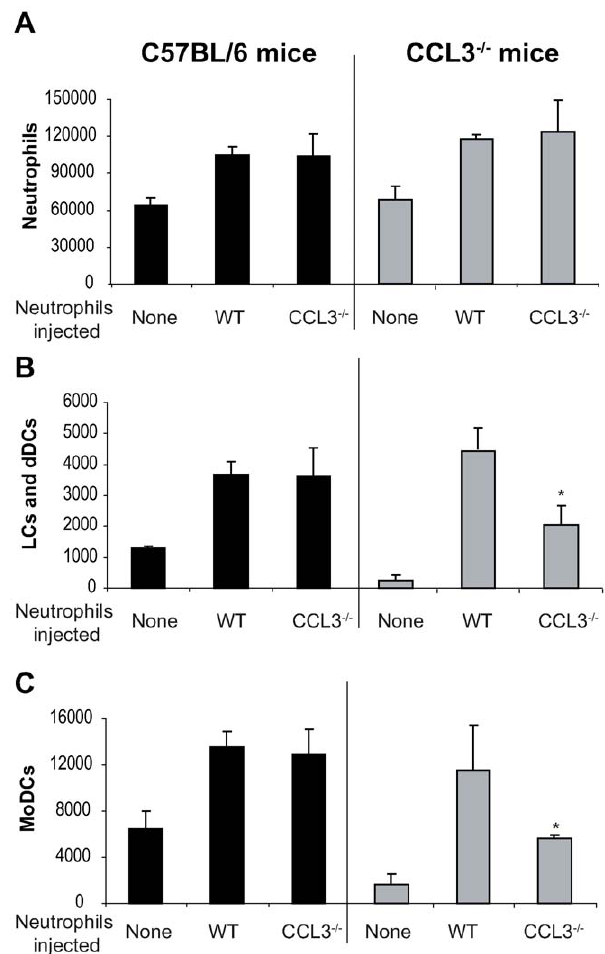
Figure 6. The CCL3 secreted by neutrophils is the major chemoattractant for DCs one day after L. major inoculation. Inflammatory neutrophils from C57BL/6 or CCL3 2 / 2 mice were injected in the ear dermis of C57BL/6 or CCL3 2 / 2 mice simultaneously with L. major . (A) The neutrophils, (B) Langerhans cells, dermal DCs, and (C) monocyte-derived DCs emigrating from the ear explants were monitored 24 hours post inoculation. Data obtained from four individual mice are expressed as mean values 6 SEM. The results are representative of three experiments. * : p , 0.05 compared with injection with WT